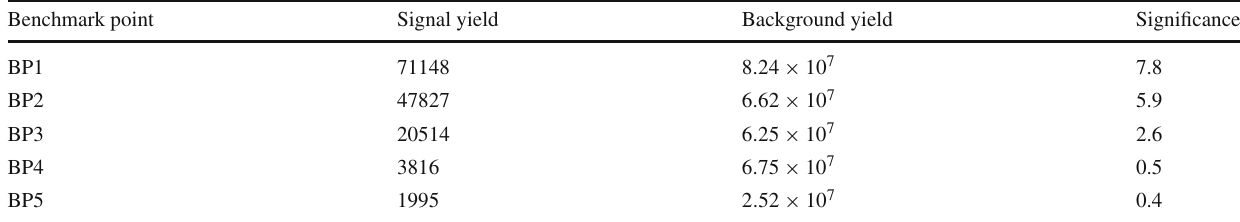
Table 8 The signal and background yields at 14 TeV-LHC with 3 ab − 1 integrated luminosity for BP1,BP2, BP3, BP4 and BP5 along with signal significances for the pp → 1 (cid:3) + E T / channel after performing the BDTD analysis